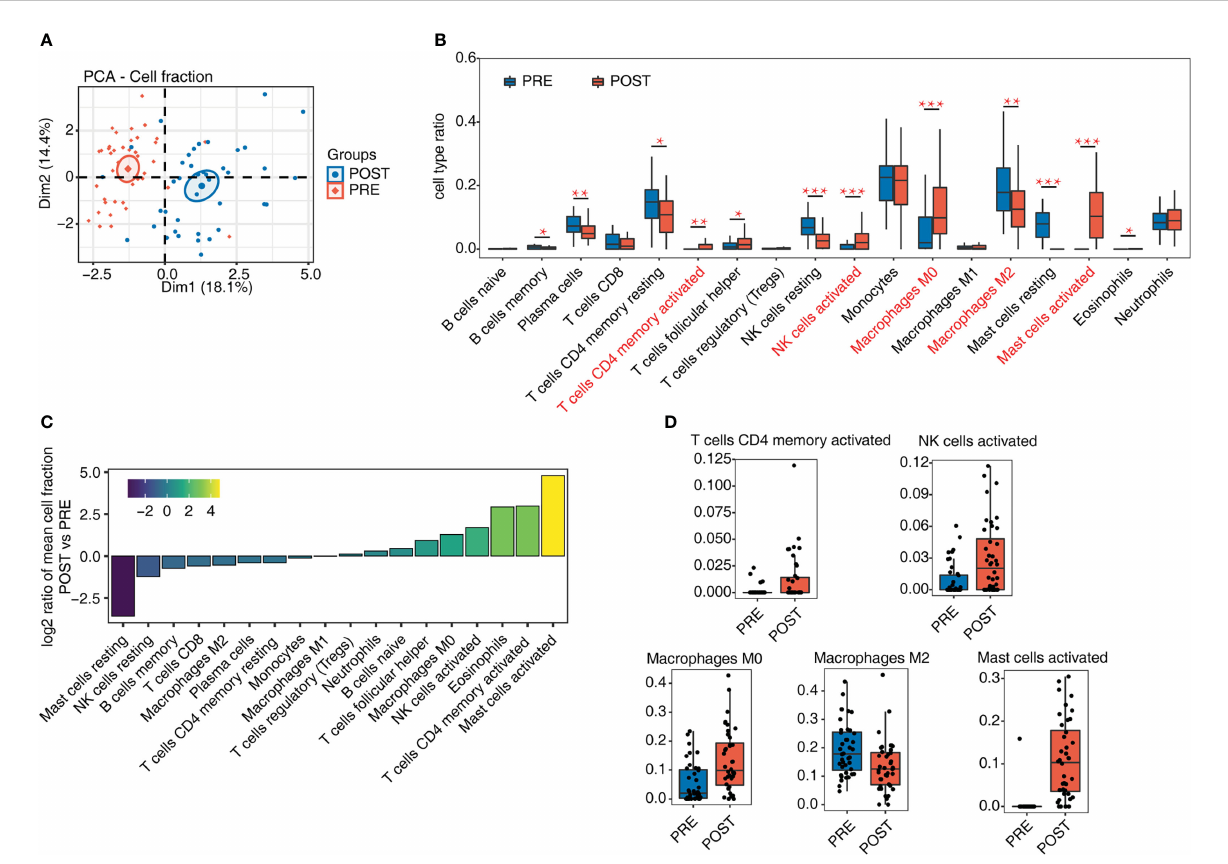
FIGURE 1 Diversity of immune microenvironment characteristics before and after LT. (A) PCA based on the fractions of different cells before and after LT. The ellipse for each group is the con fi dence ellipse. (B) Box plot shows the fraction of each cell type in each group. Student ’ s t -test is used to calculate the signi fi cant differences of cell fractions between PRE and POST samples. * P -value < 0.05, ** P -value < 0.01, *** P -value < 0.001. (C) Bar plot shows the relative frequency ratio between POST vs. PRE for each cell type that is ranked based on decreasing values. (D) Box plot shows the fraction distribution of 5 immune cell